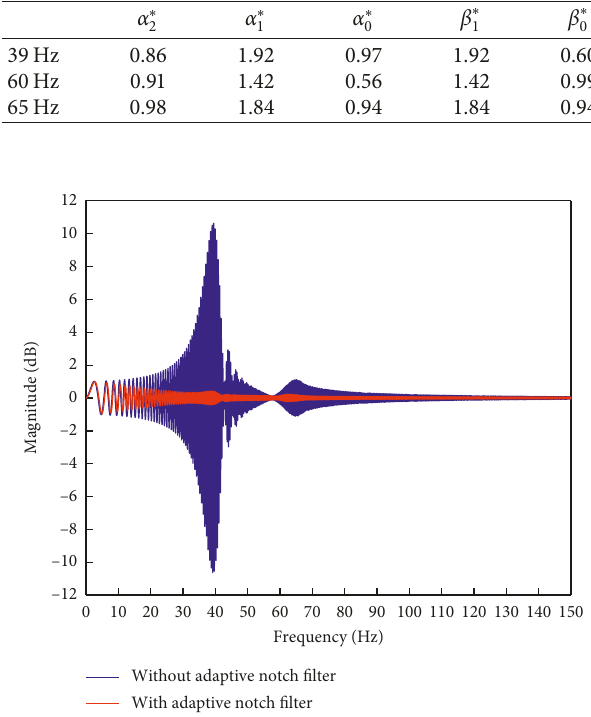
Figure 9: The sine sweep frequency response of simulation.